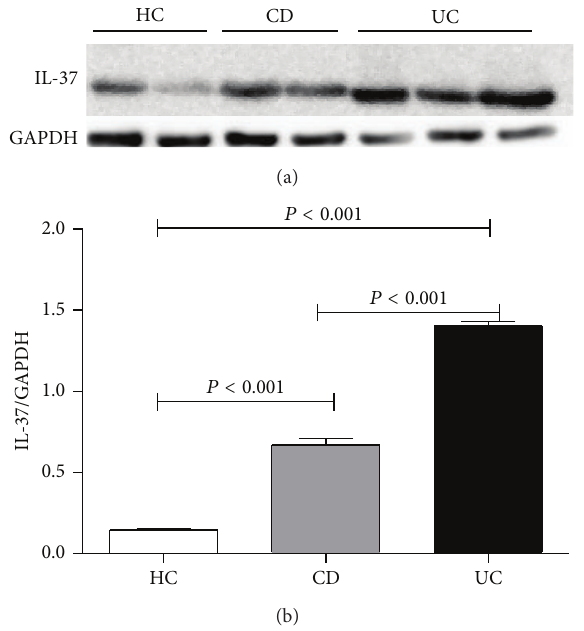
Figure 7: Detection of IL-37 in protein extracts of endoscopic specimens by Western blot. Representative Western blot of IL-37 and GAPDH (a) proteins levels in UC and CD patients and healthy controls. IL-37 protein expression was found to be higher in UC patients and CD patients compared to healthy subjects and the expression levels of IL-37 protein were higher in the samples of UC patients than that of CD samples